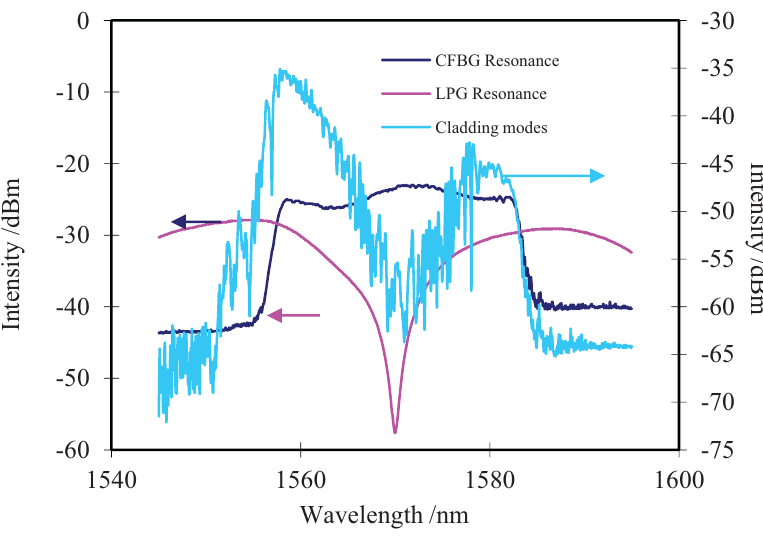
Figure 2. Spectra of LPG and CFBG before and after splicing.